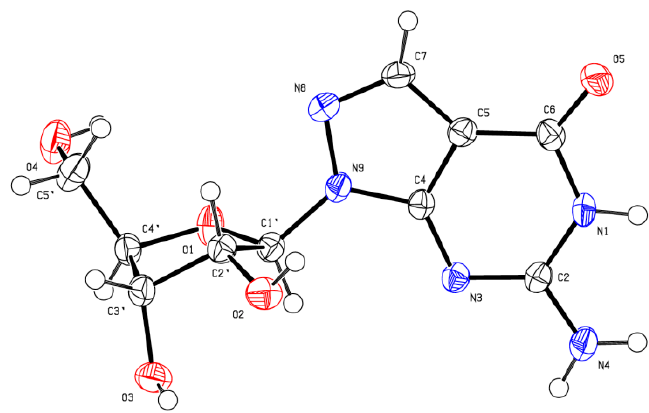
Figure 5. Molecular structure of compound 7 taken from the X-ray analysis. Crystal Data for C 10 H 13 N 5 O 5 ( M = 283.25 g/mol): orthorhombic, space group P2 1 2 1 2 1 (no. 19), a = 4.7669 (2) Å, b = 11.0409 (5) Å, c = 21.6334 (9) Å, V = 1138.59 (8) Å 3 , Z = 4, T = 293 (2) K, µ (CuK α ) = 1.157 mm − 1 , Dcalc = 1.652 g/cm 3 , 4100 reflections measured (8.174° ≤ 2 Θ ≤ 134.138°), 2032 unique ( R int = 0.0304, R sigma = 0.0405) which were used in all calculations. The final R 1 was 0.0366 (I > 2 σ (I)) and wR 2 was 0.0924 (all data).